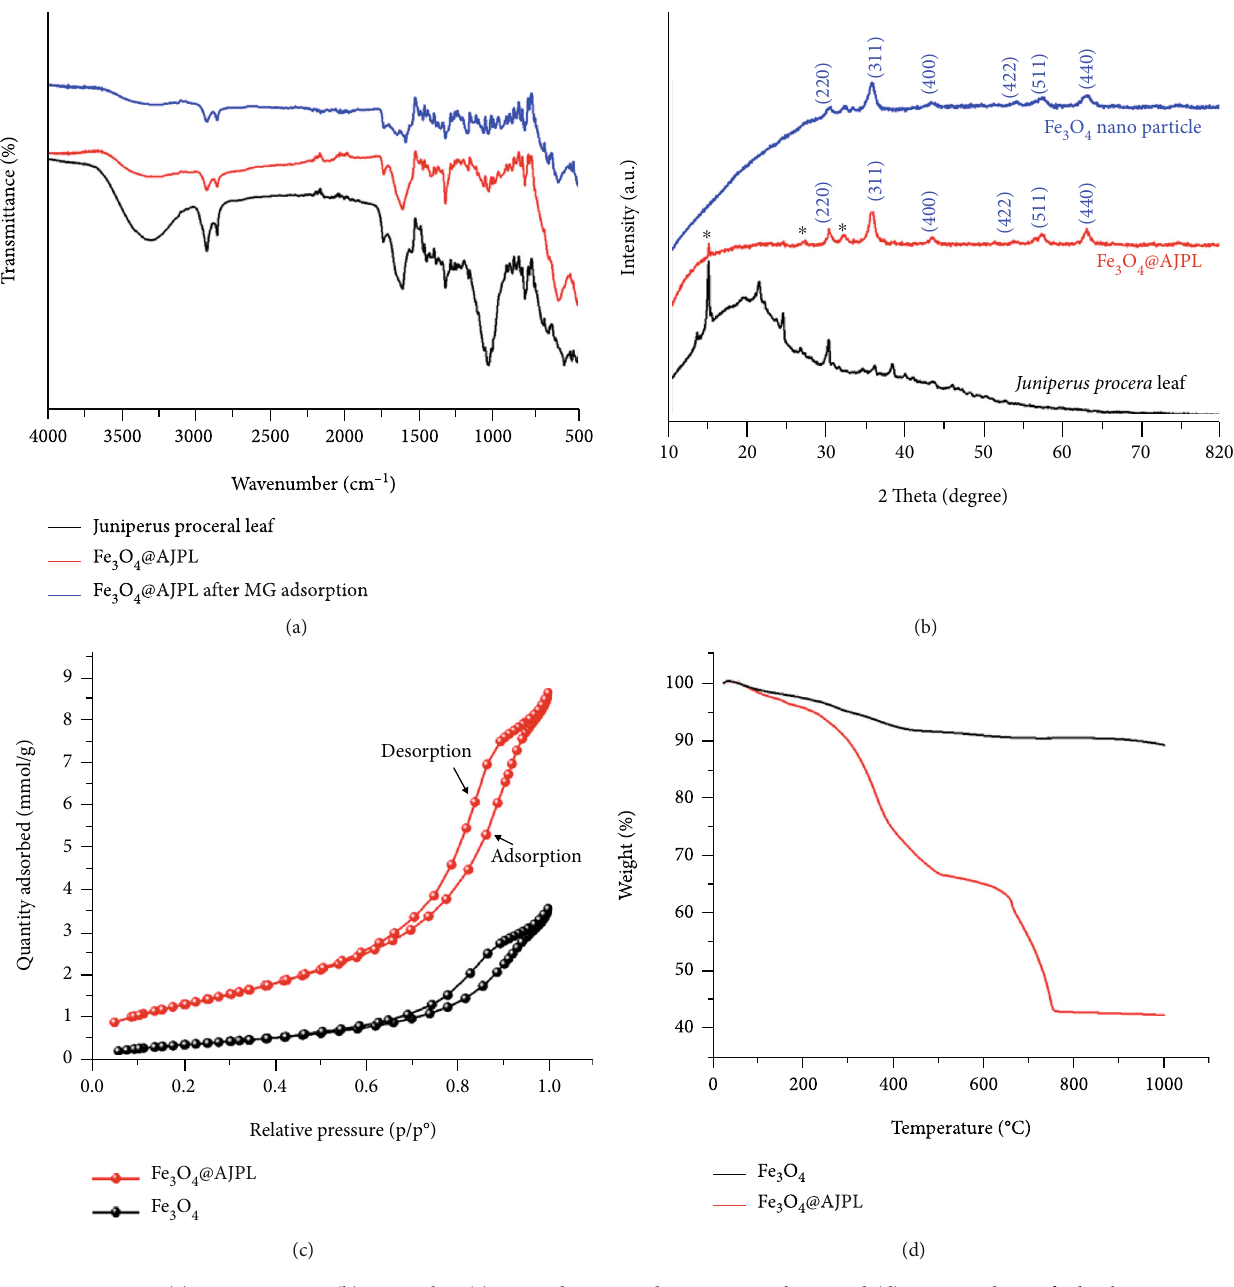
Figure 2: (a) FT-IR spectra, (b) XRD plot, (c) BET adsorption-desorption analysis, and (d) TGA analysis of